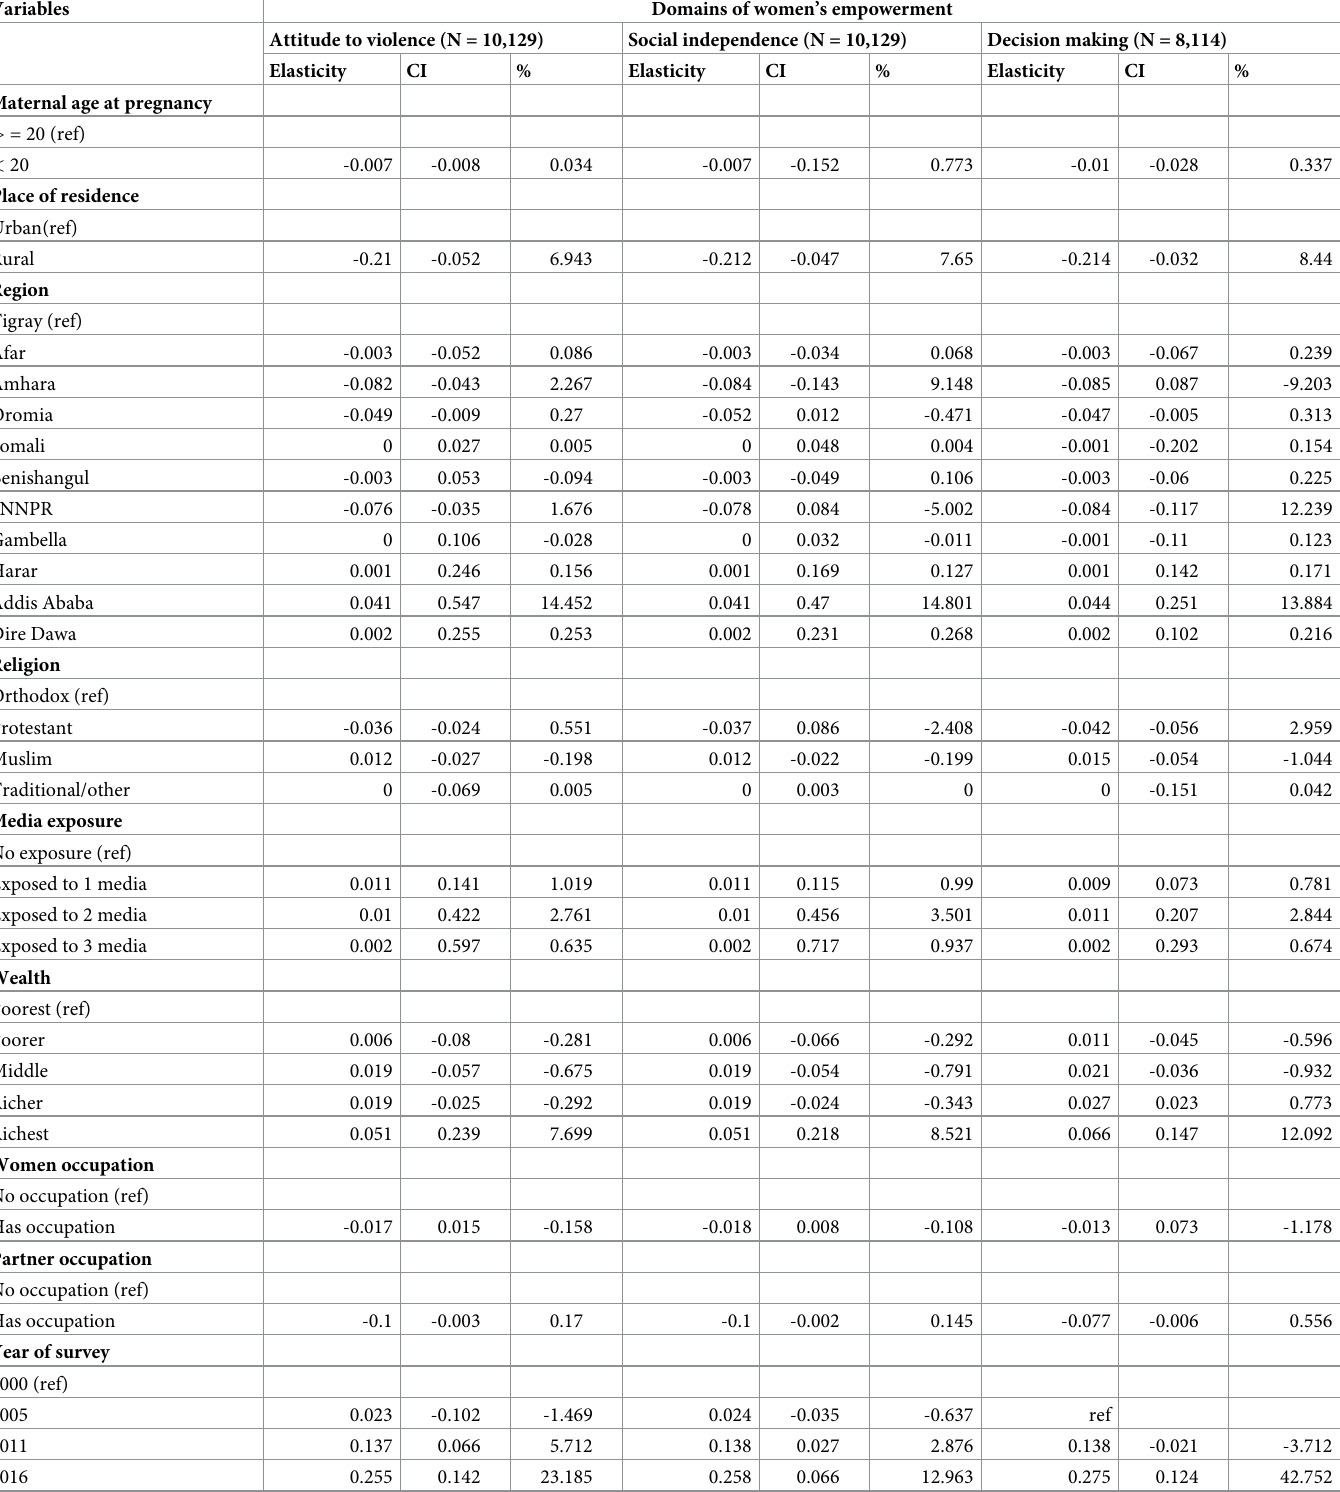
Table 2. Decomposition of the inequalities in the usage of quality ANC by women’s empowerment, 2000–2016